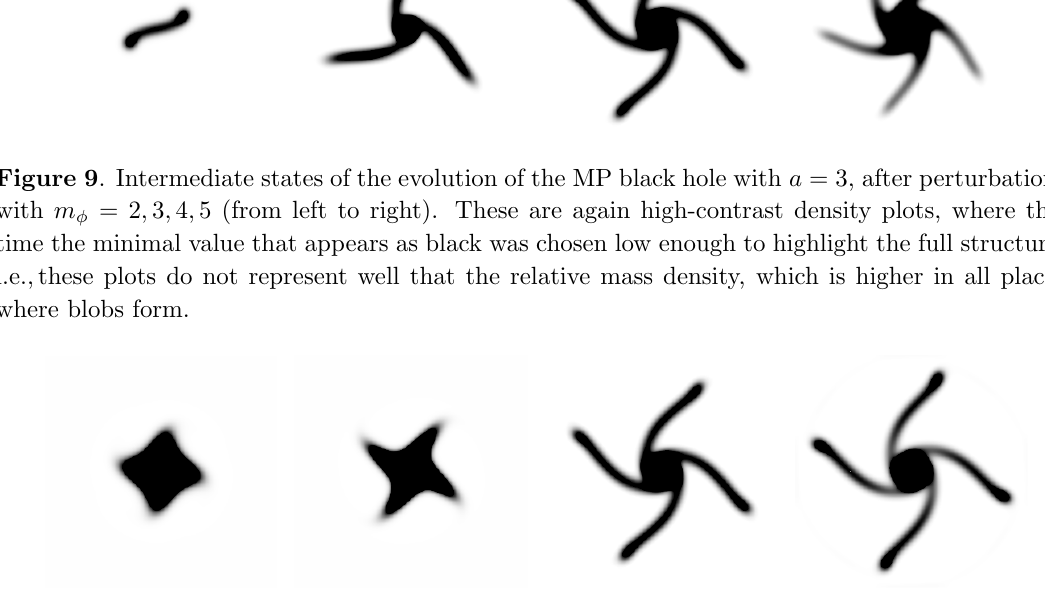
Figure 10 . Snapshots of time evolution for the MP black hole with a = 3, perturbed by the = 4 fundamental m φ